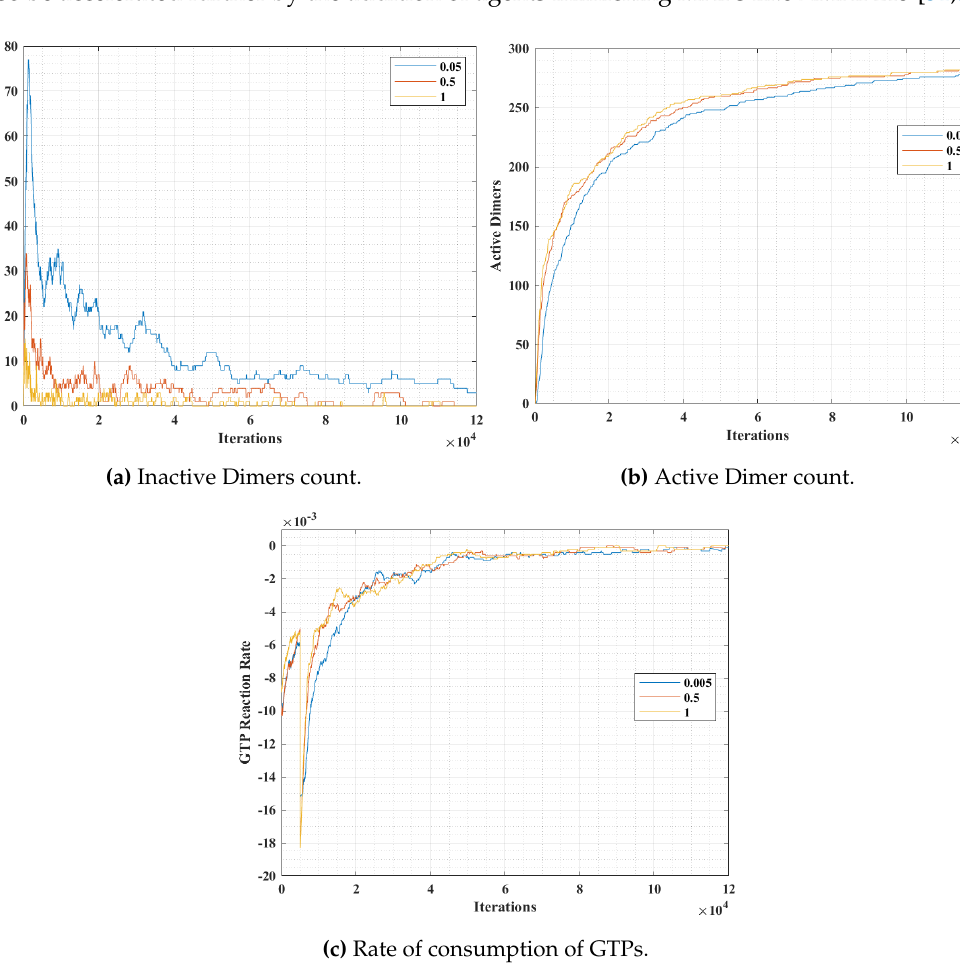
Figure 13. Analysis results of simulation 2, with varying P